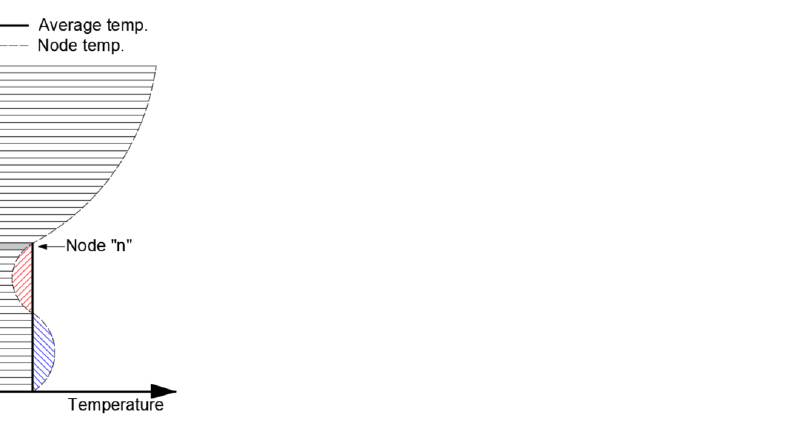
Figure 6. Application of the natural convection algorithm inside the hot water tank after water draws. Temperature distribution before (dashed line) and after (continuous line) the application of the algorithm.